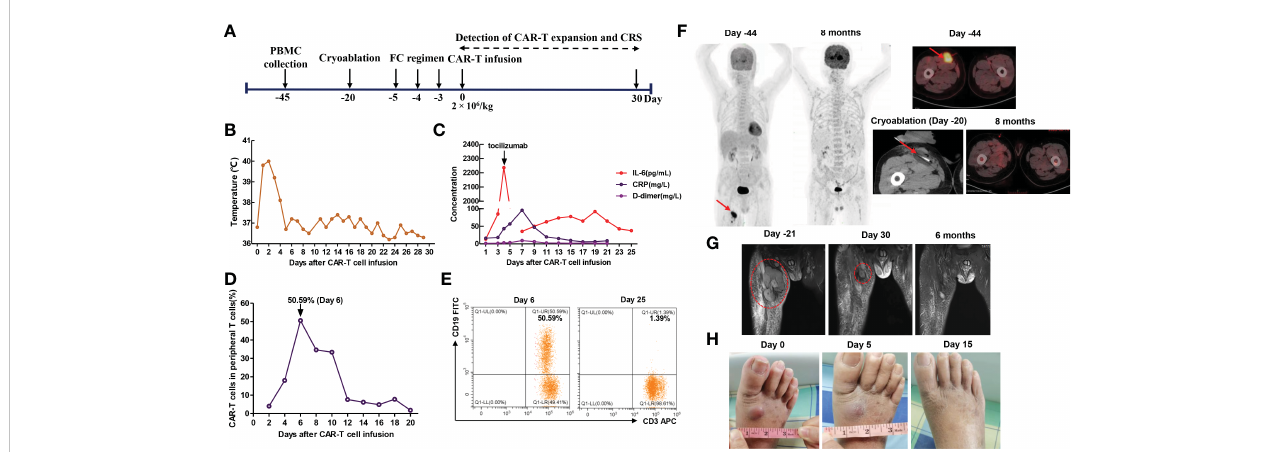
FIGURE 4 (A) Timeline of patient preparation and CAR-T therapy for patient 2 from peripheral blood collection to 1 month after anti-CD19 CAR-T cell infusion, including bridging cryoablation, lymphodepleting chemotherapy, and CAR-T cell infusion. (B) Changes in body temperature after CAR-T cell infusion. (C) The levels of IL-6, C-reactive protein and D-dimer in serum at different time points after CAR-T cell infusion. (D, E) The percentage of anti-CD19 CAR-T cells in peripheral T cells at different time points. The plot was gated on CD3+ cells (T cells). (F) CT-guided percutaneous cryoablation rapidly induced liquefaction necrosis of the bulky thigh mass, PET/CT showed that the right thigh mass remained in remission 8 months after CAR-T cell infusion. (G) MRI revealed that the thigh mass was remarkably decreased 1 month after the combination of cryoablation and CAR-T therapy and it was completely eliminated 6 months after CAR-T cell infusion. (H) Combination therapy induced the remission of newly emerging distant metastases 15 days after CAR-T cell